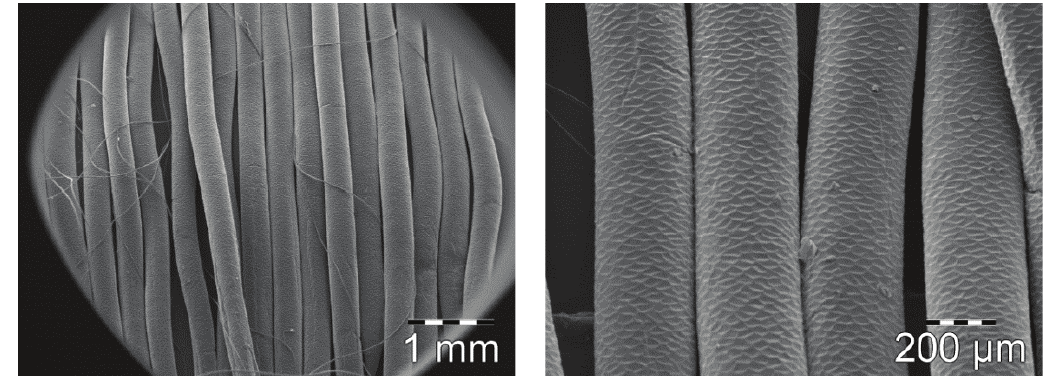
Figure 5. SEM images of guard hairs from the back of the winter pelage of reindeer. Left: low magnification. Right: high magnification. Comparison of these images with those in Figure 4 shows that the guard hairs of musk deer are substantially thicker than those of reindeer. See also Table 1.